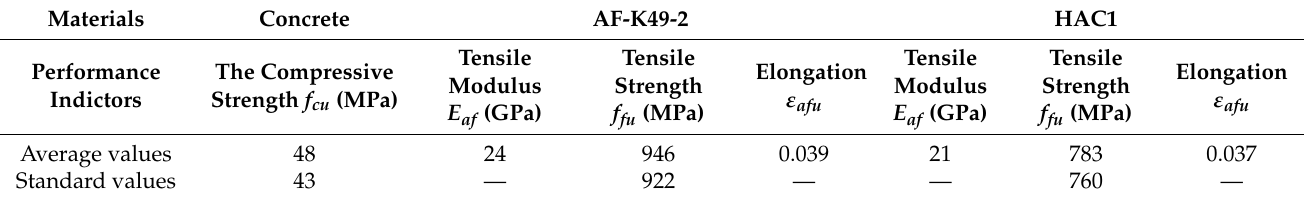
Table 3. The material properties of beam specimens.